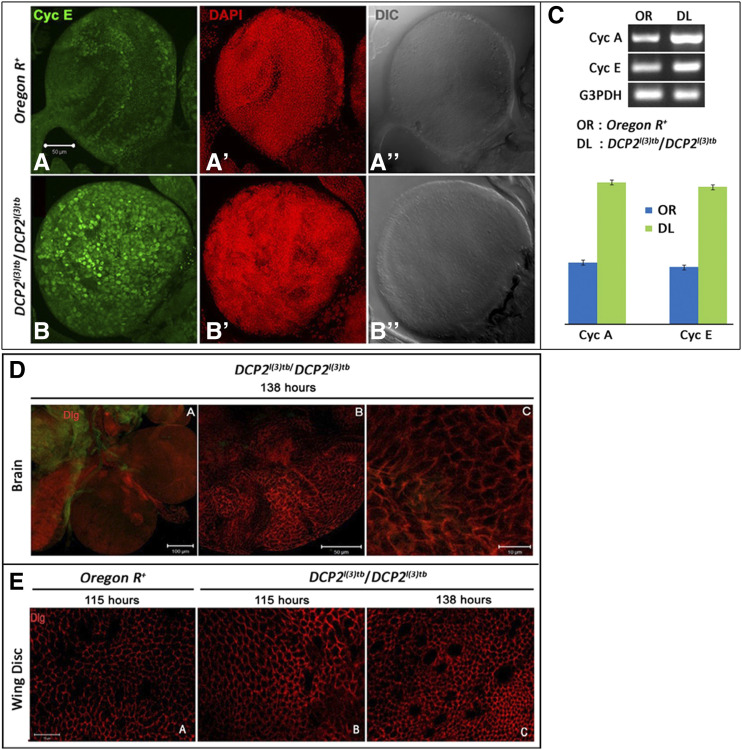
The tumor caused by DCP2 is hyperplastic with elevated Cyclin A and E. Immunolocalisation of Cyclin E shows elevated expression in the tumorous larval brains of DCP2l(3)tb homozygotes (B) as compared to the wild type (A). Semi-quantitative analyses of mRNA expression of Cyclins A and E show similar elevation in the brain of DCP2l(3)tb homozygotes (C). Expression of Discs-large in the brain (D) and wing discs (E) of the tumorous individuals did not show appreciable loss. At 138h AEL, the wing discs showed increase in cell number concomitant with decrease in cell size (E.C) whereas, at the same stage, the tumorous brain shows increased number of cells at in the optic lobe (D).